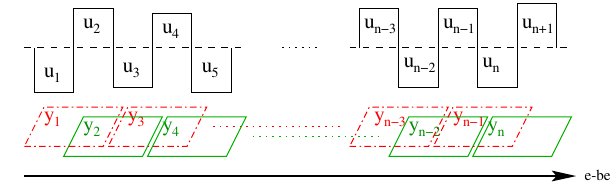
FIG. 1. (Color) Concept of induction shimming. The sinusoidal field in one of the undulator halves is approximated for the sake of simplicity by a rectangular shape. Because of minor field errors caused by finite tolerances, the amplitude of the field varies slightly. This variation is compensated by HTSC loops arranged in the way shown in this picture. The length of one loop in the beam direction is exactly one ideal period